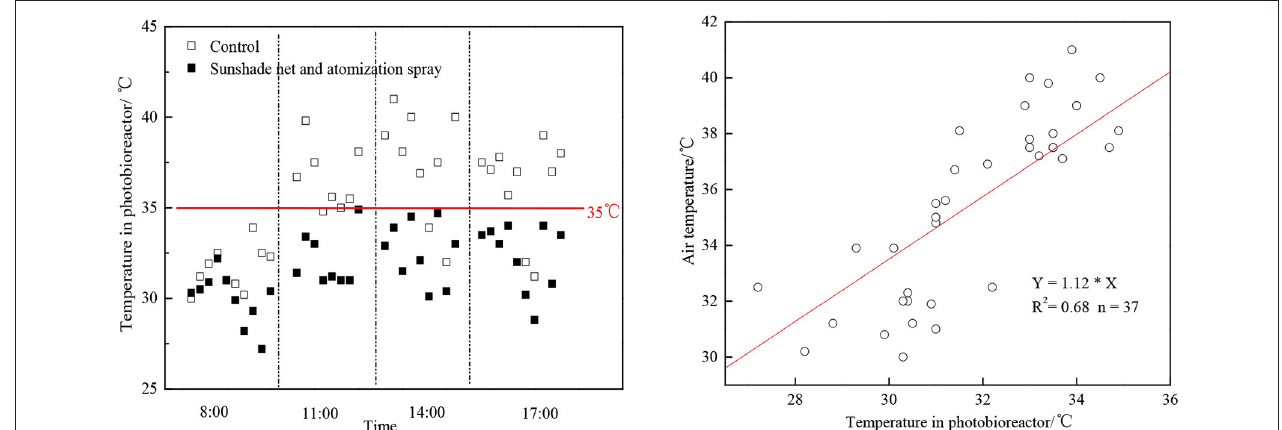
FIGURE 2 | Temperature reduction effects of combining sunshade nets and atomization spray.